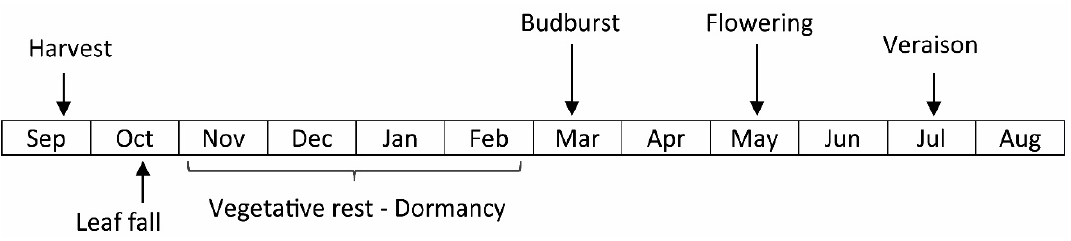
Figure 2. Typical annual cycle of grapevine growth in the DDR.